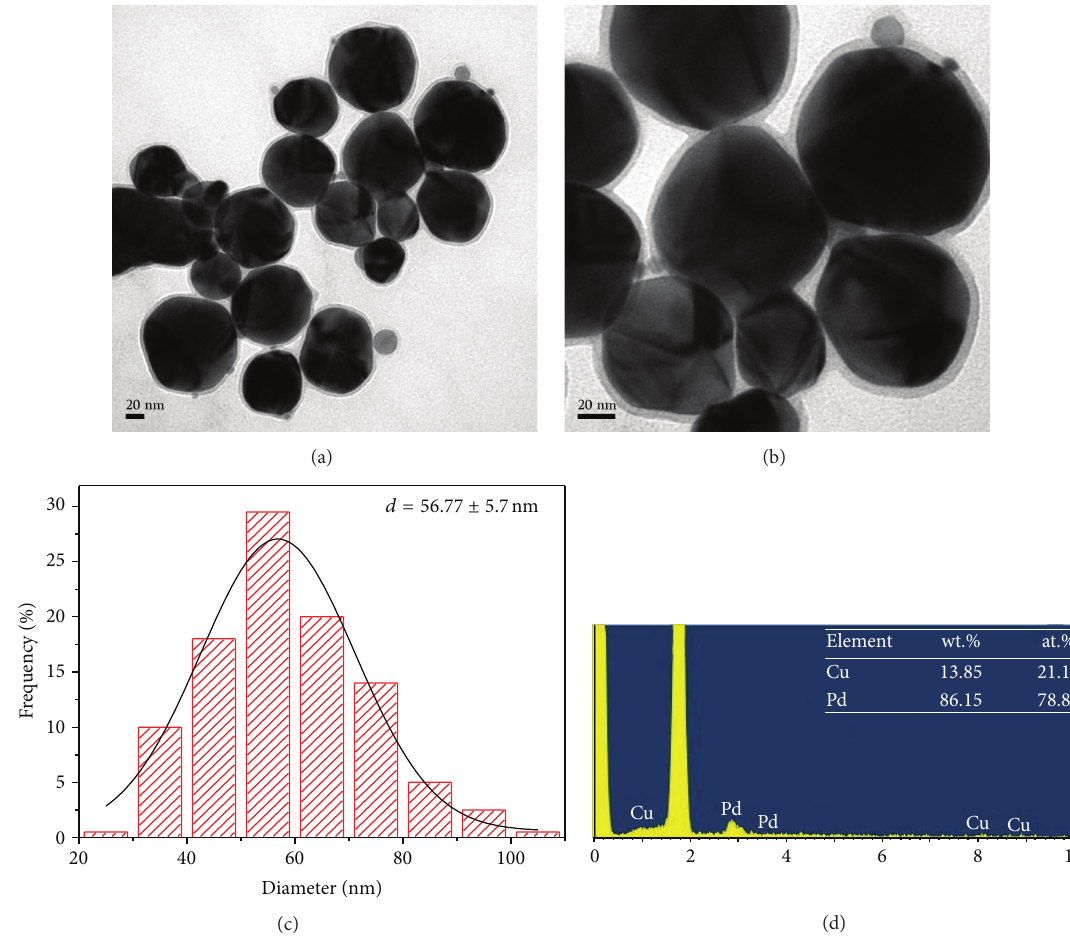
Figure 2: (a, b) Typical TEM images of Pd-Cu near-spherical NPs with different magnifications. (c) Particle size distribution analysis. (d) EDS spectrum of the corresponding NPs.